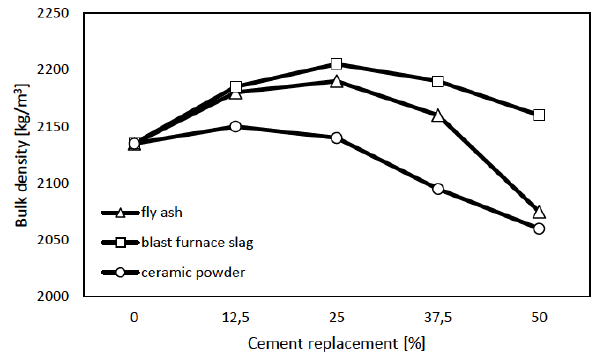
Figure 2: Bulk density of studied mixtures after 90 days [kg/m 3 ].